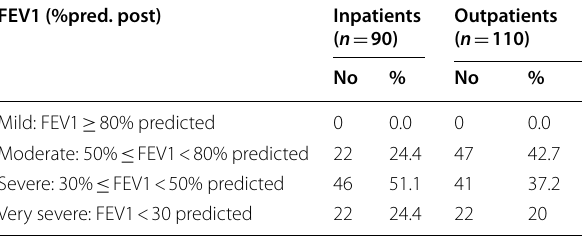
Severity (by FEV1) based on Muneswarao et al. [11]